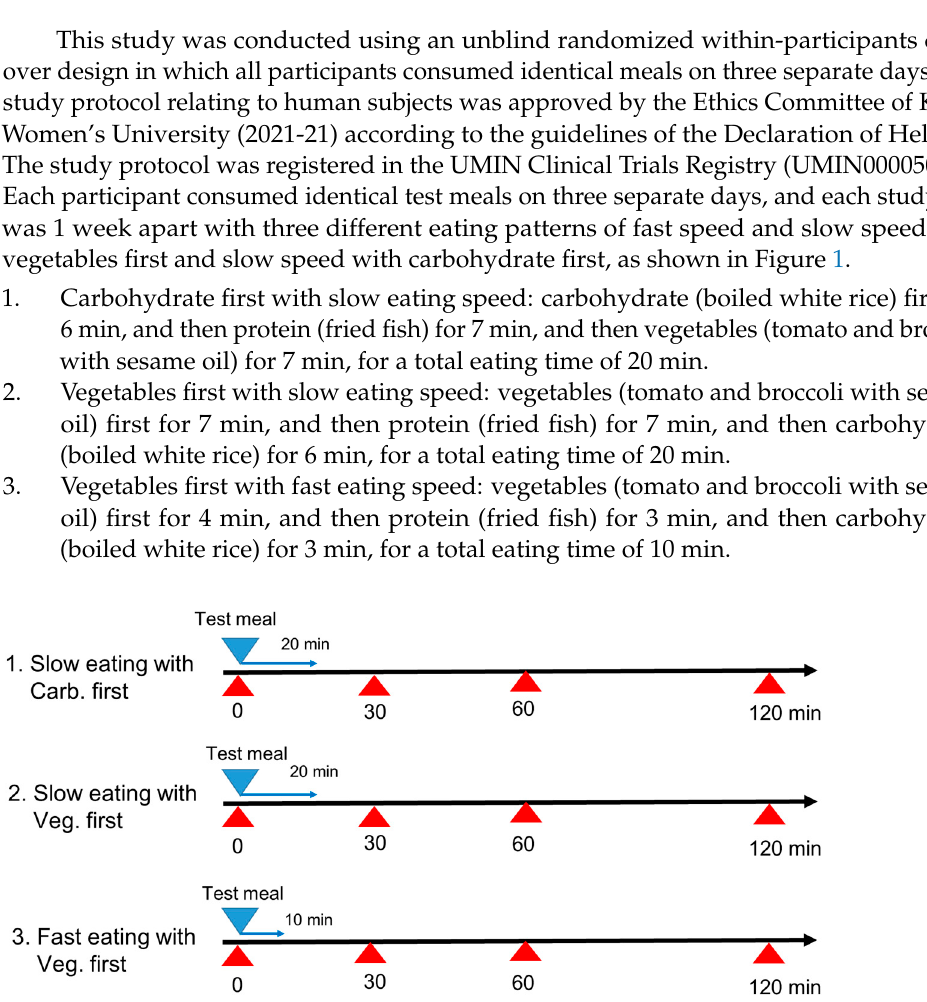
Figure 1. Study protocol. All participants consumed identical test meals in 3 different eating patterns: eating slow (20 min) with carbohydrate first, eating slow (20 min) with vegetables first, and eating fast (10 min) with vegetables first. Each meal was consumed at 9:00 under the following experimental conditions that were assigned in the unblind randomized cross-over trial: 1. Carbohydrate first with slow eating speed: carbohydrate (boiled white rice) first for 6 min, and then protein (fried fish) for 7 min, and then vegetables (tomato and broccoli with sesame oil) for 7 min, for a total eating time of 20 min. 2. Vegetables first with slow eating speed: vegetables (tomato and broccoli with sesame oil) first for 7 min, and then protein (fried fish) for 7 min, and then carbohydrate (boiled white rice) for 6 min, for a total eating time of 20 min. 3. Vegetables first with fast eating speed: vegetable (tomato and broccoli with sesame oil) first for 4 min, and then protein (fried fish) for 3 min, and then carbohydrate (boiled white rice) for 3 min, for a total eating time of 10 min. Blood samples were collected at 0, 30, 60, and 120 min after consuming the test meals. Postprandial blood glucose, insulin, triglyceride (TG) and free fatty acid (FFA) concentrations were examined. Veg.; vegetables, Carb.; carbohydrate.